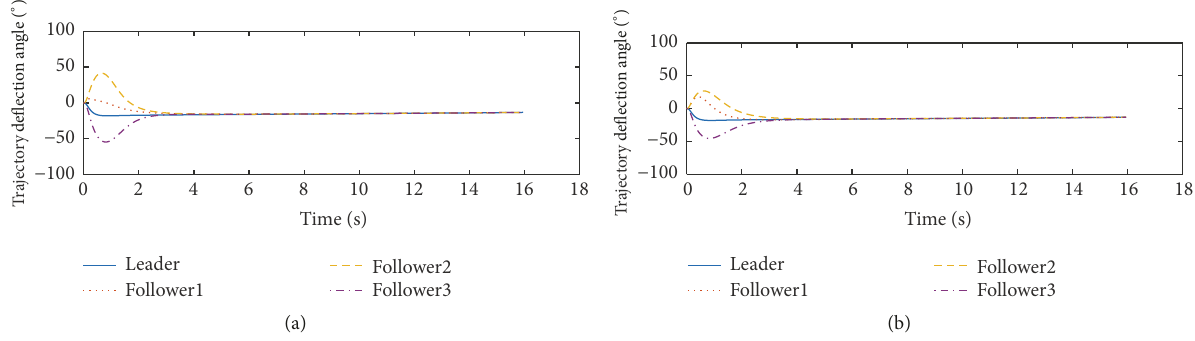
Figure 7: Trajectory deflection angle curve in the global and local communication topology: (a) trajectory deflection angle curve in global communication topology; (b) trajectory deflection angle curve in local communication